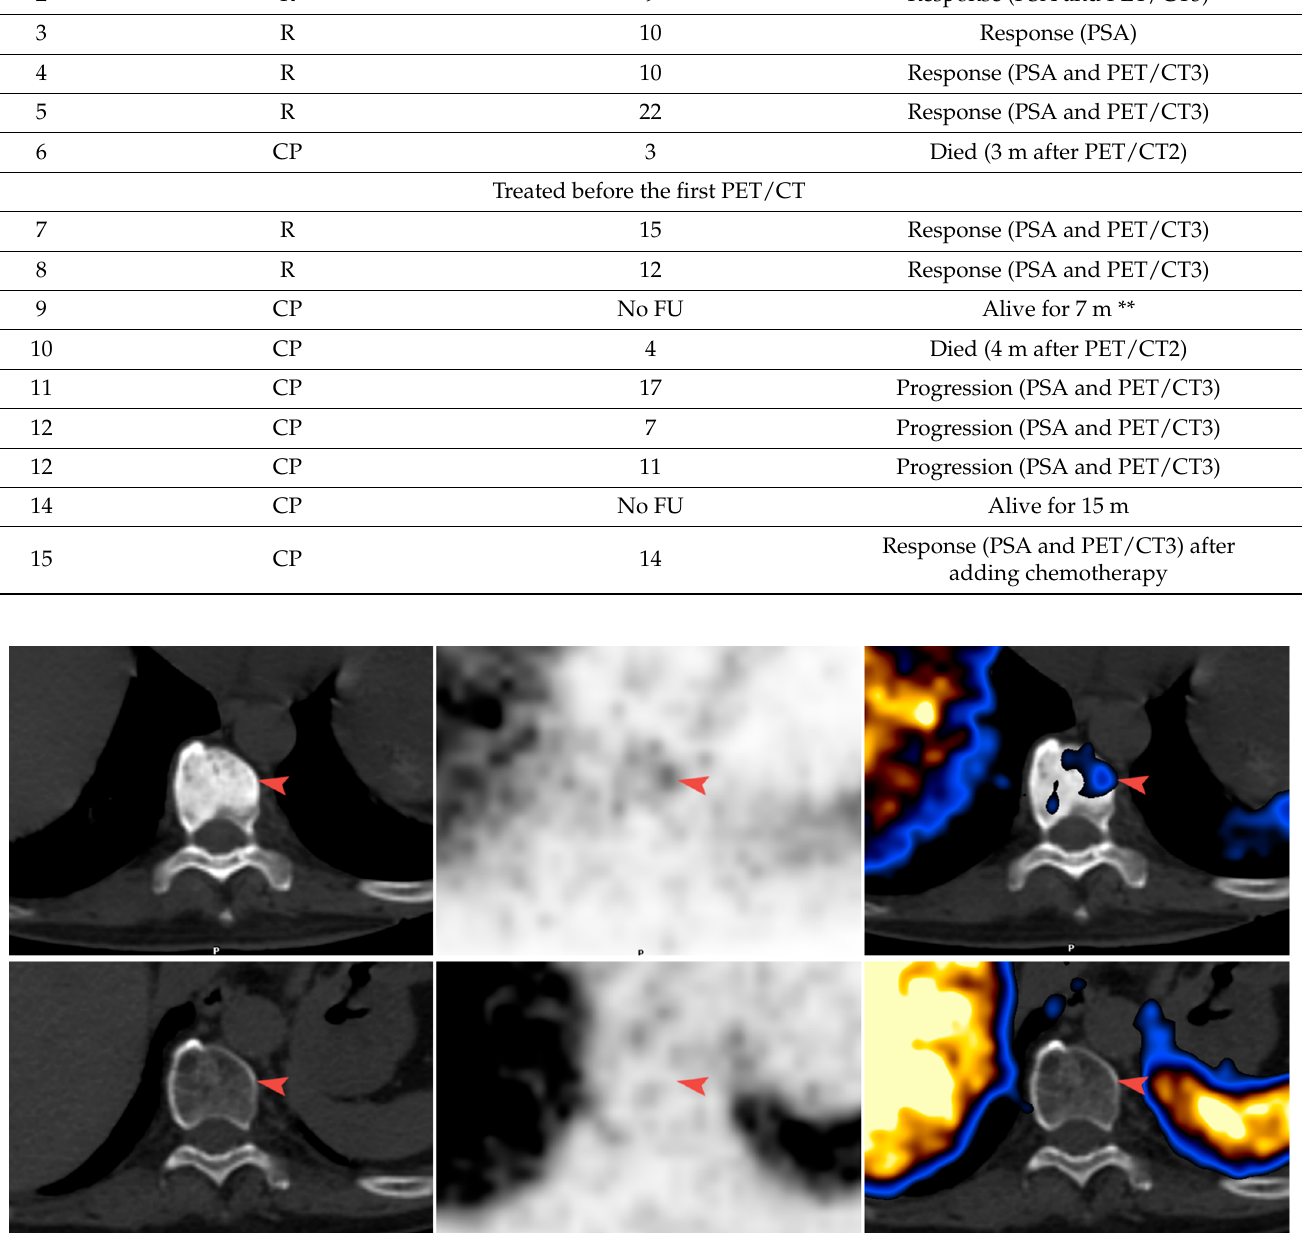
Figure 2. Clinical progression (Patient 14). (From left to right) CT; PET; and fusion images. In the first scan after ADT, sclerotic metastases in the vertebra were identified in pelvic bones with very low uptake of 68Ga-PSMA-11 (arrowhead) (top row). In the second scan, the lesions were no longer sclerotic and showed intense 68Ga-PSMA-11 uptake (bottom row). PSA levels increased and a new metastasis was detected (arrow). 4. Discussion The current study addresses the challenge in differentiating between dense bone metastases of PCa that show a reduction in bone density because of active disease, probably representing castration resistance, and those that show a reduction as a response